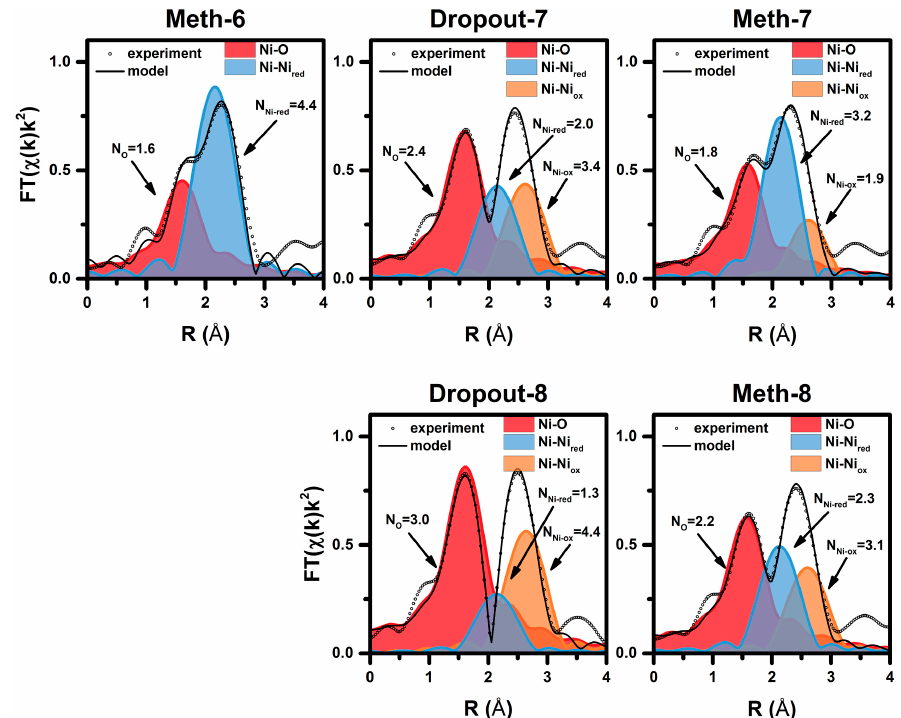
Figure 6. Experimental and simulated FT EXAFS data (magnitude, not phase shift corrected) of the Ni catalyst during 30-s modulation, in addition, the estimated Ni coordination numbers (Cycles 6–8), k -range 3–9 Å − 1 , k -weight = 2 (for details, see the Supplementary Materials). Table 1. Structural parameters of the local Ni atomic environment extracted from the best fitting EXAFS spectra shown in Figure 6. k range = 3–9 Å − 1 , R range = 1.2–3.2 Å, N ind = 6, N var = 5, a = fitted uncertainty 0.01 or lower, f = fixed during fit, N = number of neighboring atoms, R = distance, σ 2 = mean square deviation of interatomic distance, R factor = misfit between experimental data and theory (for details, see the Supplementary Materials).